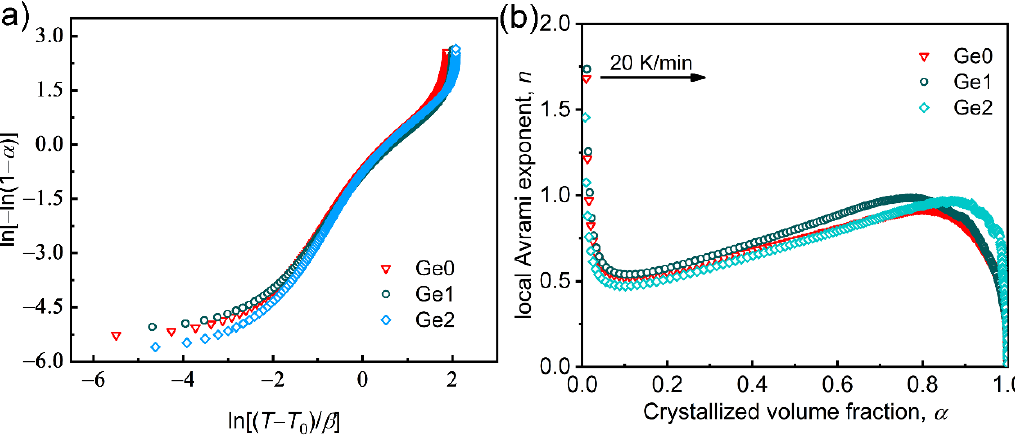
Figure 7. Plots of ln [−ln(1 − α )] versus ln[( T − T 0 )/ β ] ( a ) and local Avrami exponent, n , as a function of crystallized volume fraction α for the first crystallization peak of the alloys at a heating rate of 20 K/min ( b ).